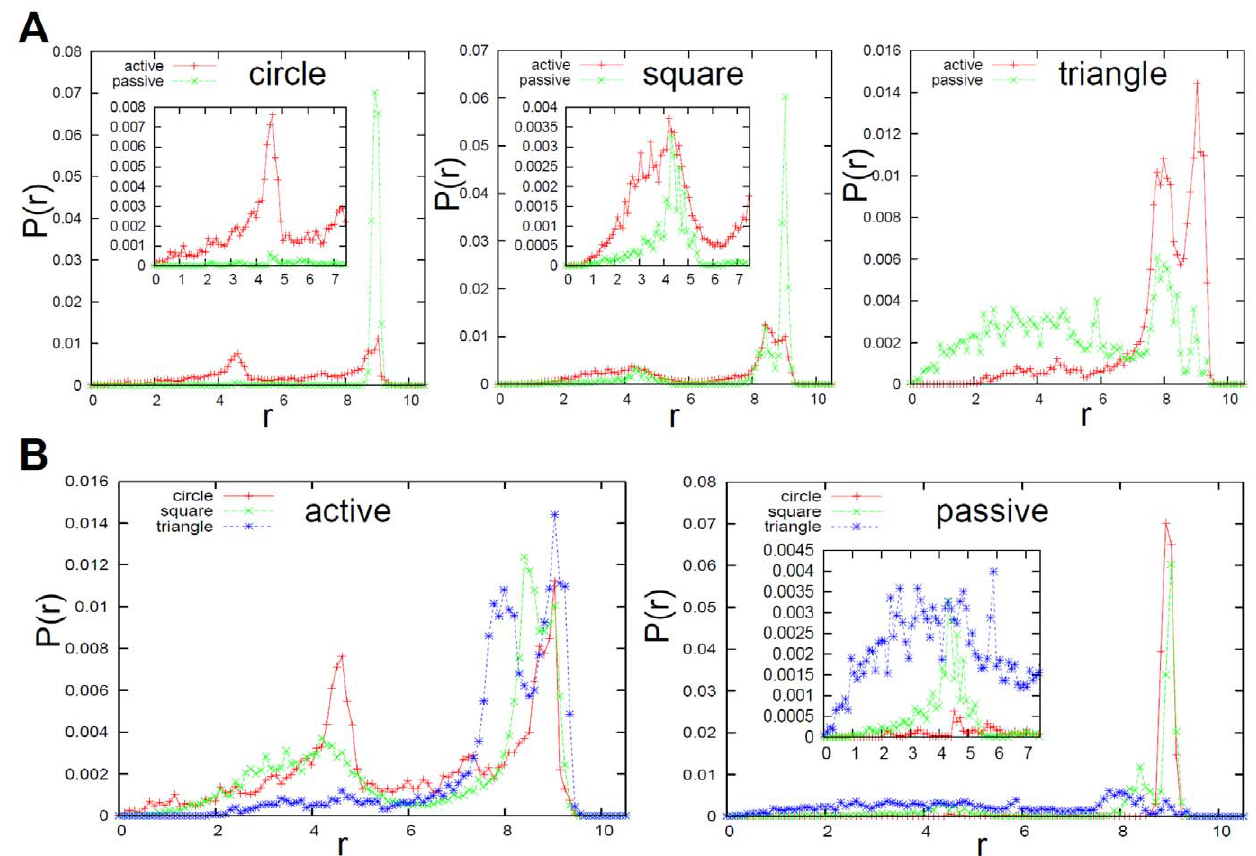
Figure 4. Radial probability distribution of the elements in the container. We calculated the radial probability ( P ( r ) ) for the active and passive elements according to the distance from the center of the container ( r ; 0 ƒ r ƒ 10 : 5 ). To calculate the probability, we discretized 10.5 cm into 100 bins, and used the last 1200 timesteps for all of the trials. A. The existence probabilities of the active and passive elements are overlaid for the circular (left), the square (middle), and the triangular (right) element shapes. For the circles and squares in particular, the insets show the enlarged plot of the region, 0 ƒ r ƒ 7 : 5 , for the same plot. Note that the range of the vertical axis is different for these three graphs. B. The existence probabilities of the circular, square, and triangular cases are overlaid for the active (left) and passive (right) elements. Especially in the case of passive elements, the insets show the enlarged plot for the region, 0 ƒ r ƒ 7 : 5 , for the same plot. Note that the range of the vertical axis is different for these graphs.